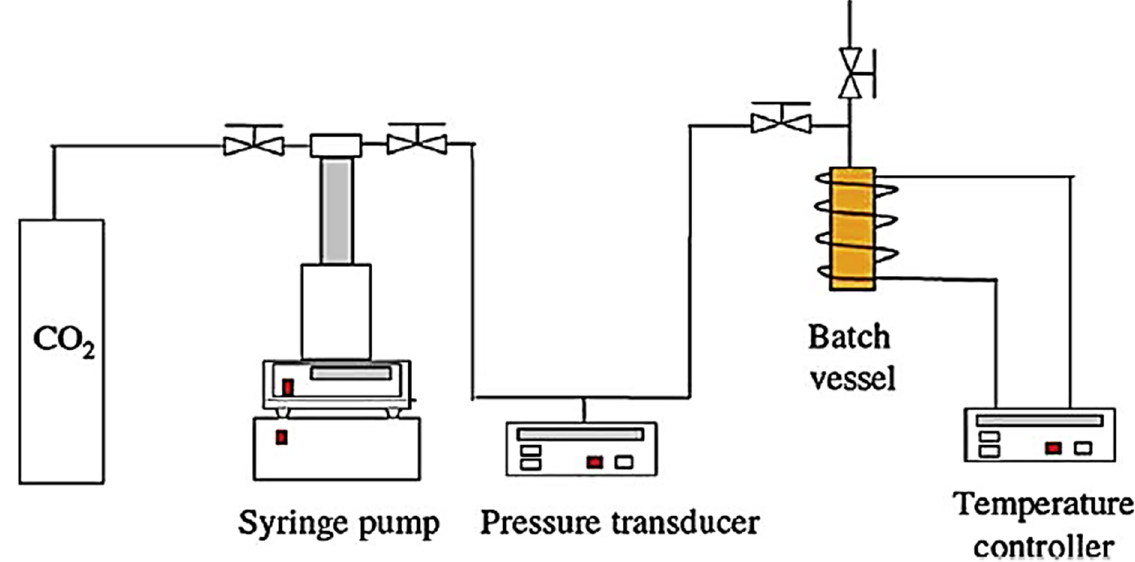
Figure 6. Schematic of the high pressure foaming system [56]. Reproduced with permission from Elsevier.